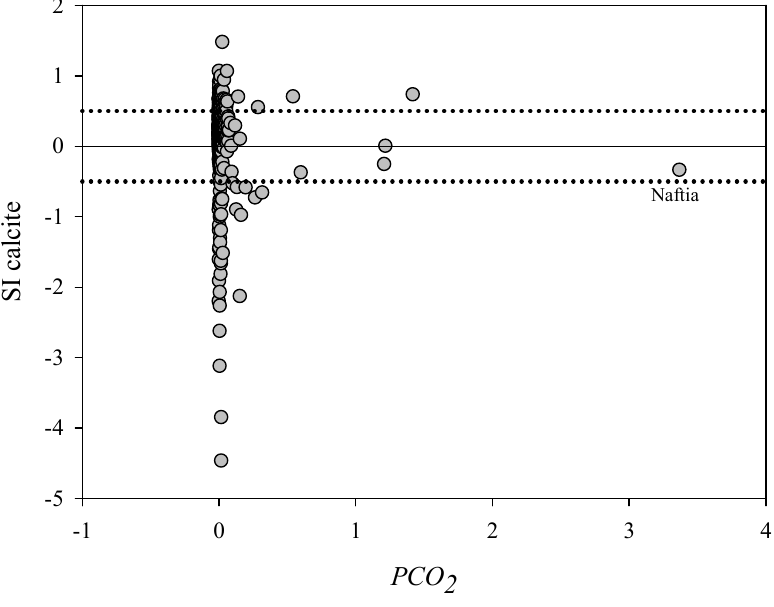
Figure 5. Saturation indexes (SIs) for calcite versus P CO 2 .